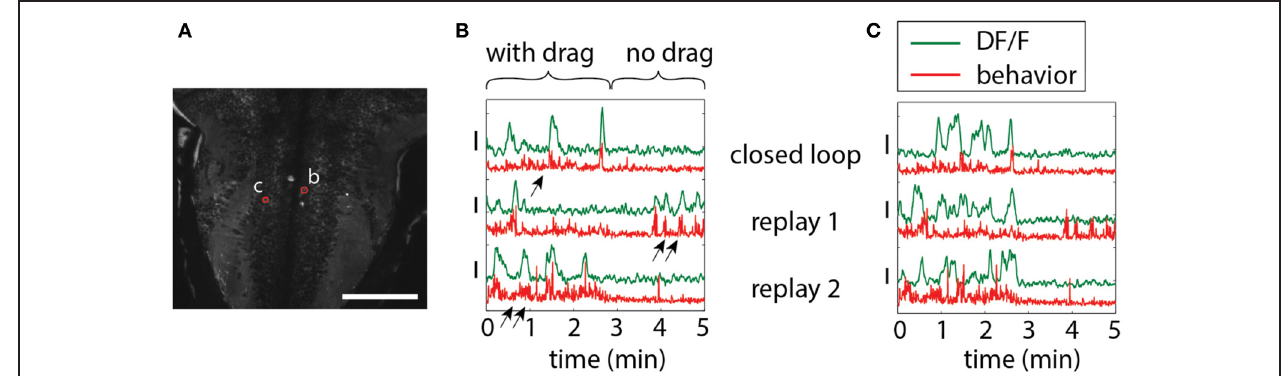
FIGURE 5 | Differences in neuronal responses to closed-loop and open-loop visual stimulation. Five minutes of closed-loop virtual behavior was followed by two replay runs, during which the recorded visual stimulus was played back in open-loop. In closed-loop, a period with drag (forward stimulus motion in the absence of swimming, simulating a backward water current) was followed by a period without drag (no stimulus motion in the absence of swimming). (A) Hindbrain anatomy, with neurons b and c marked in red. Scale bar: 100 μ m. (B) Motor-related neuronal activity, with increased fluorescence signal during more vigorous swimming. Note that the behavior,